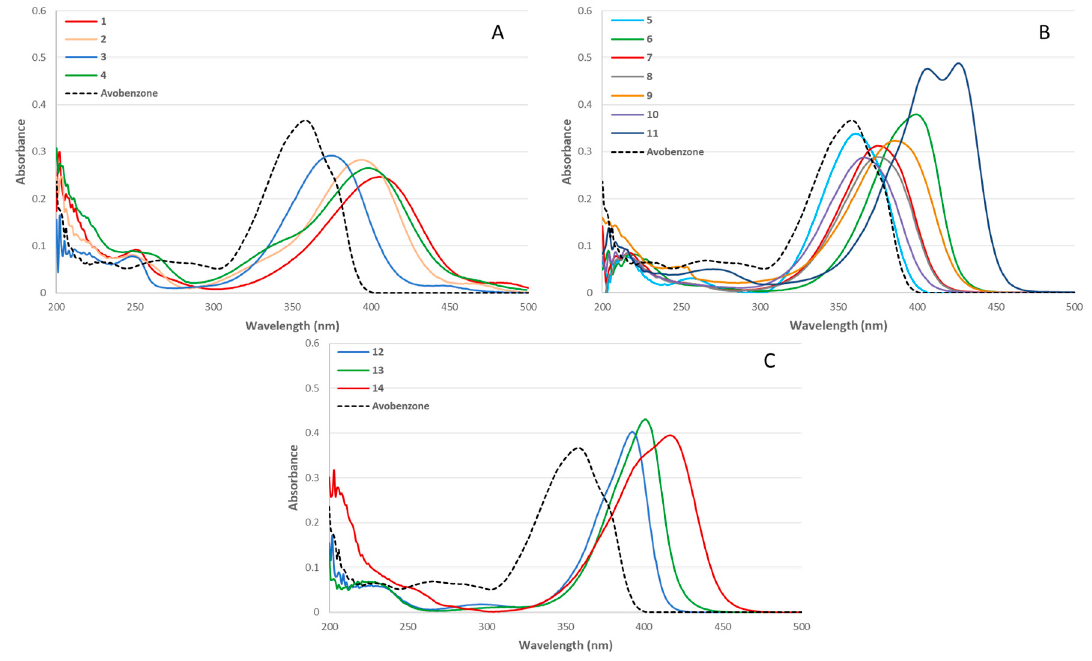
Figure 1. UV–Vis spectra for phenolic series ( A ), furanic series ( B ), and pyrrolic series ( C ), (Concentration = 10 µmol.L − 1 in ethanol).